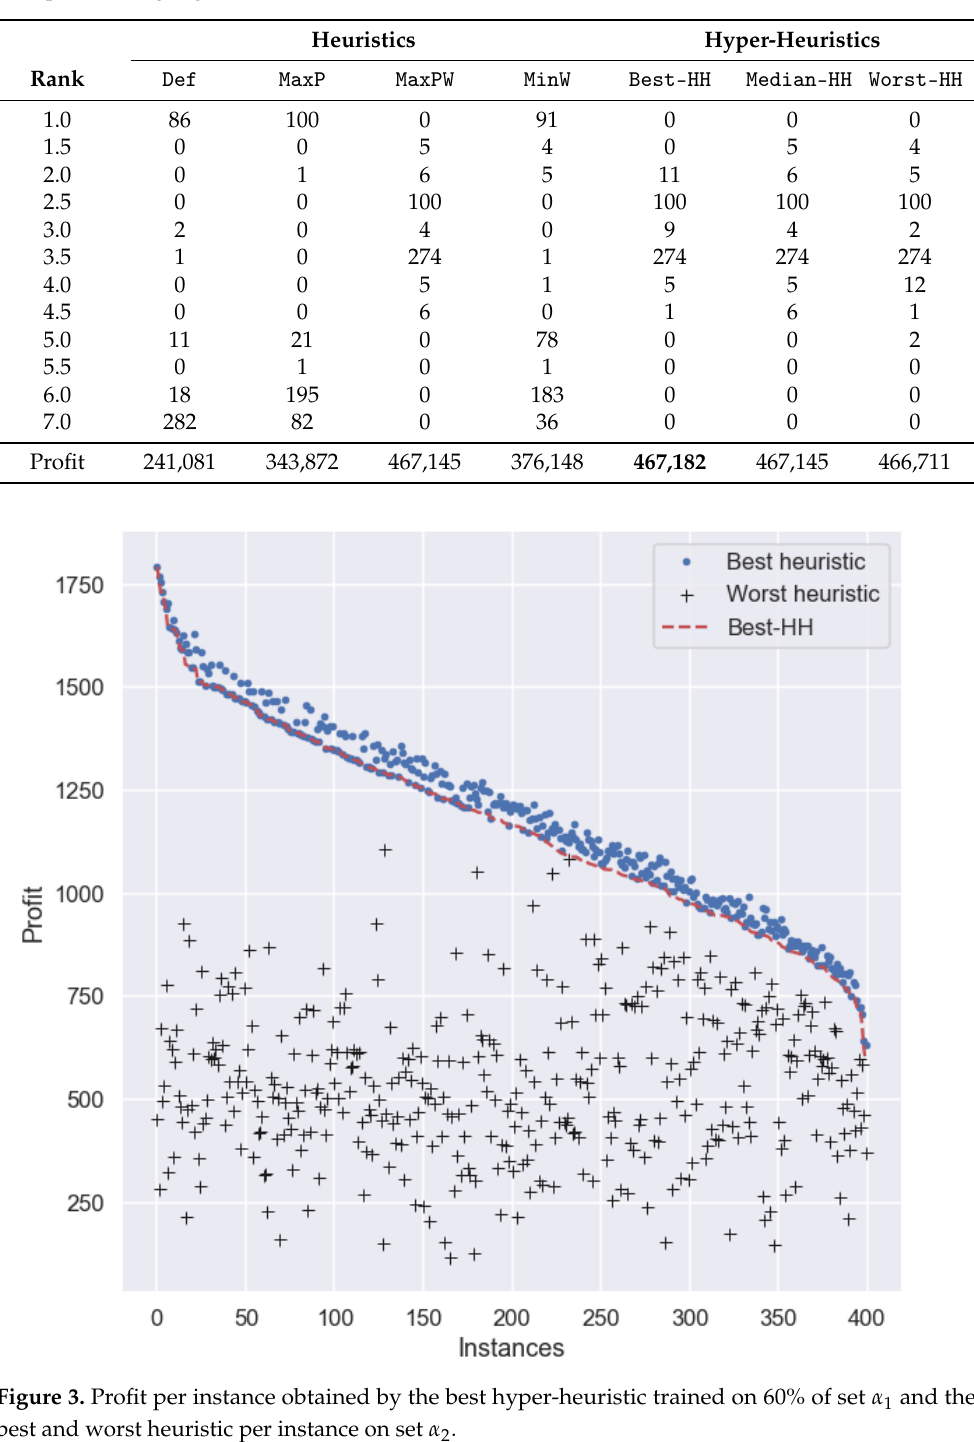
Table 5. Ranks and total profit obtained by the four heuristics and the best, median, and worst hyper-heuristics trained on 60% of set α 1 and tested on set α 2 . The best result, measured in terms of total profit, is highlighted in bold.